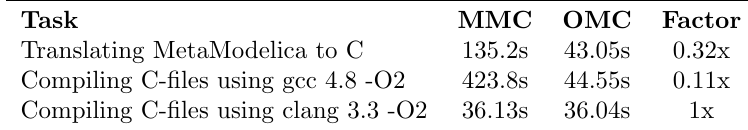
Table 7: Compiling the OpenModelica source code with the old build system (MMC) and the new one